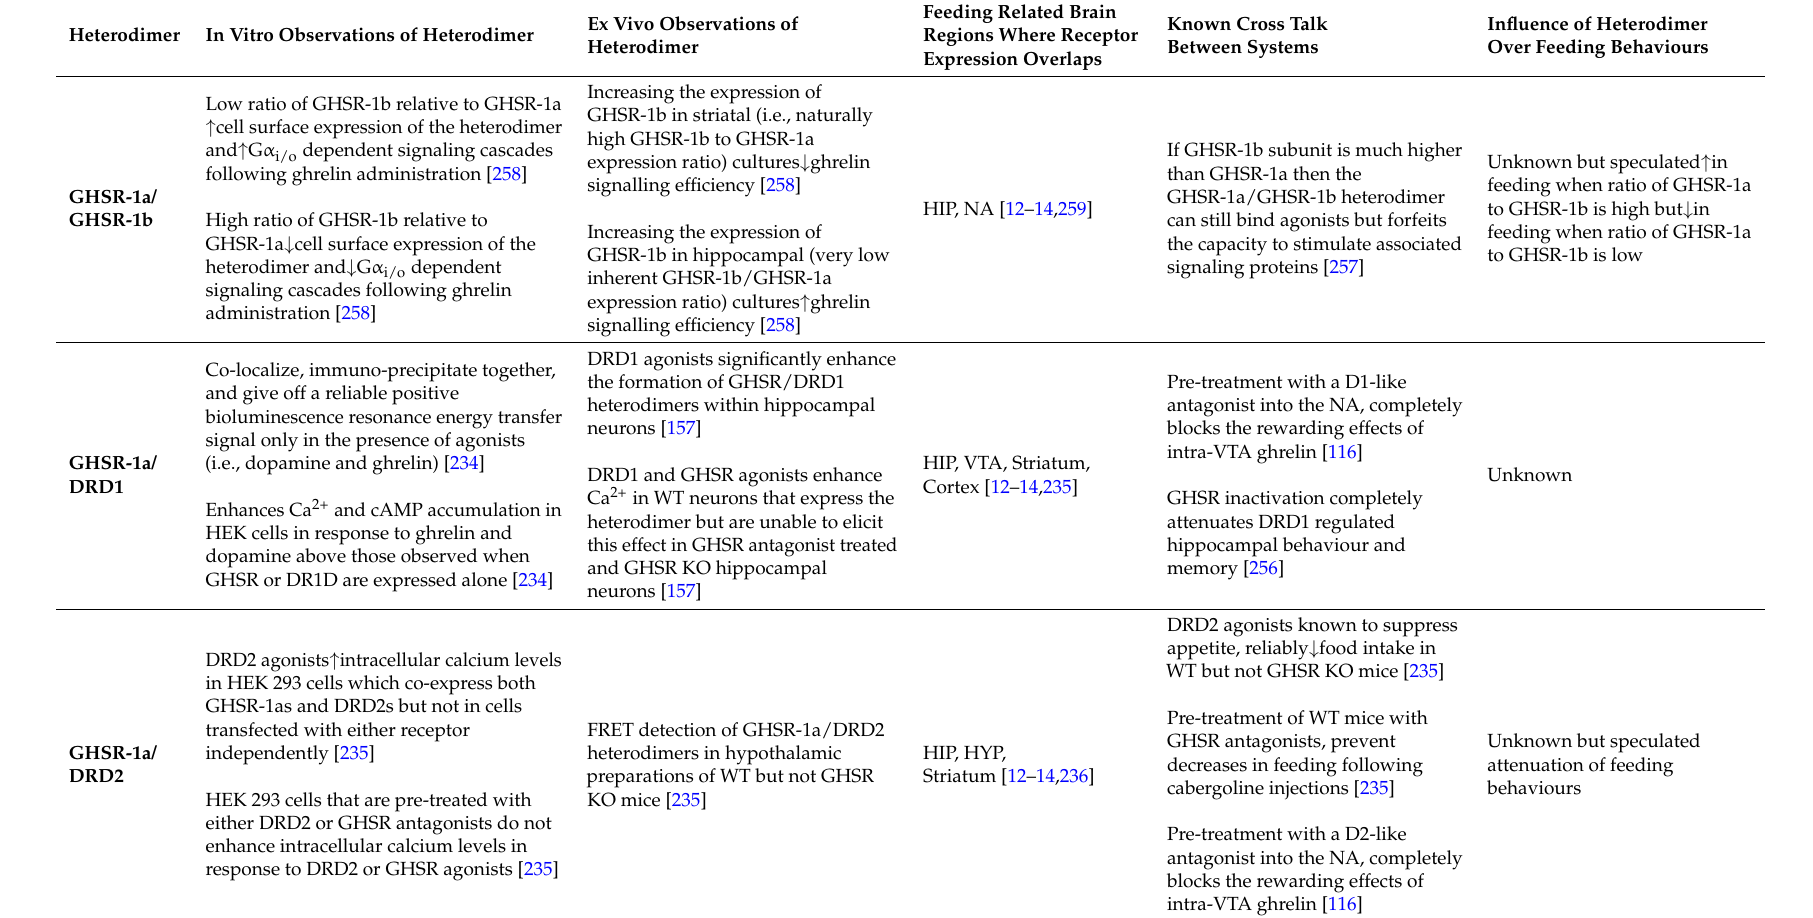
Table 2. Summary of GHSR-1a heterodimers and their putative implication in regulating feeding